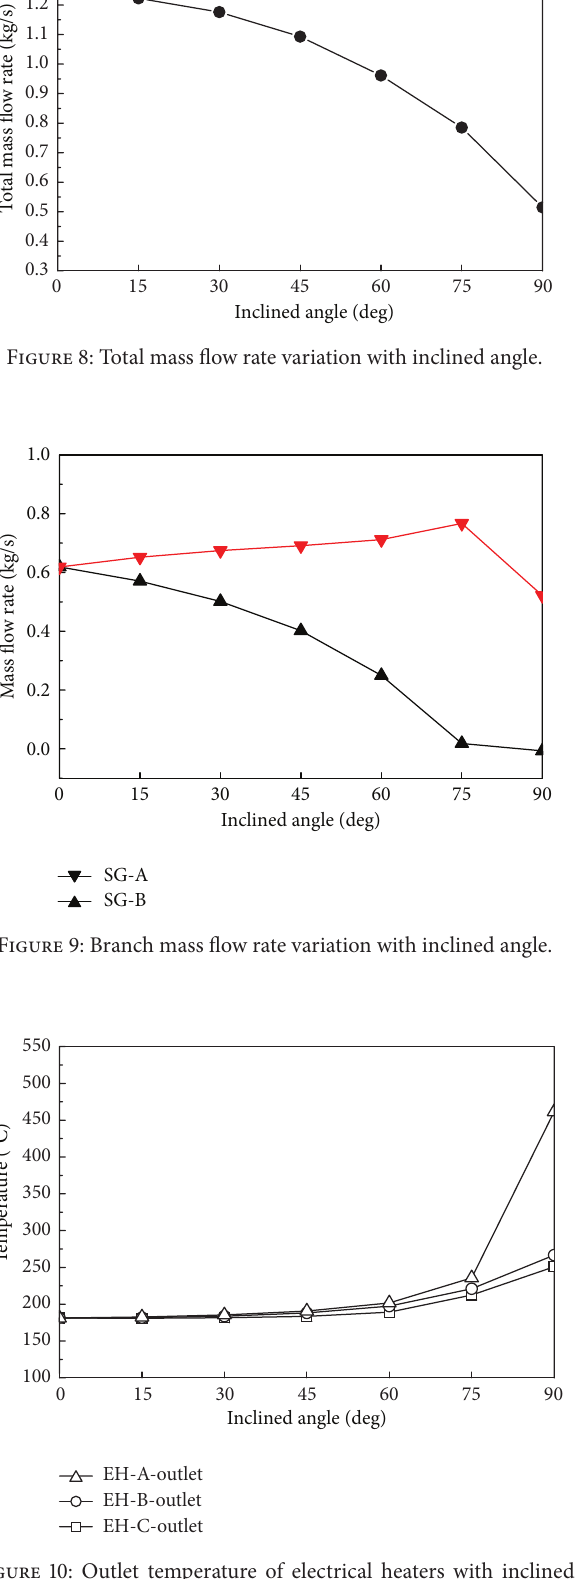
Figure 10: Outlet temperature of electrical heaters with inclined angle.